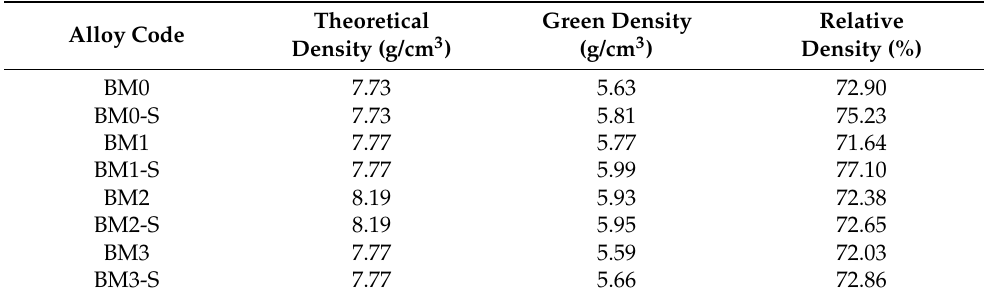
Table 3. The density of the green samples prepared at 1100 MPa for the as milled and stress relieved